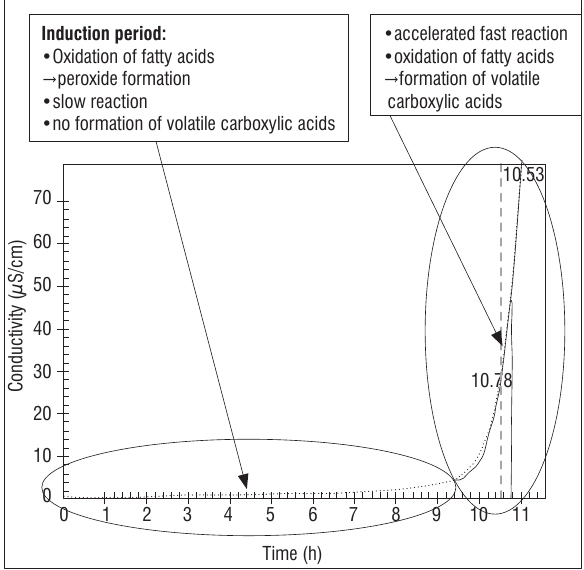
Typical curve obtained with a Rancimat